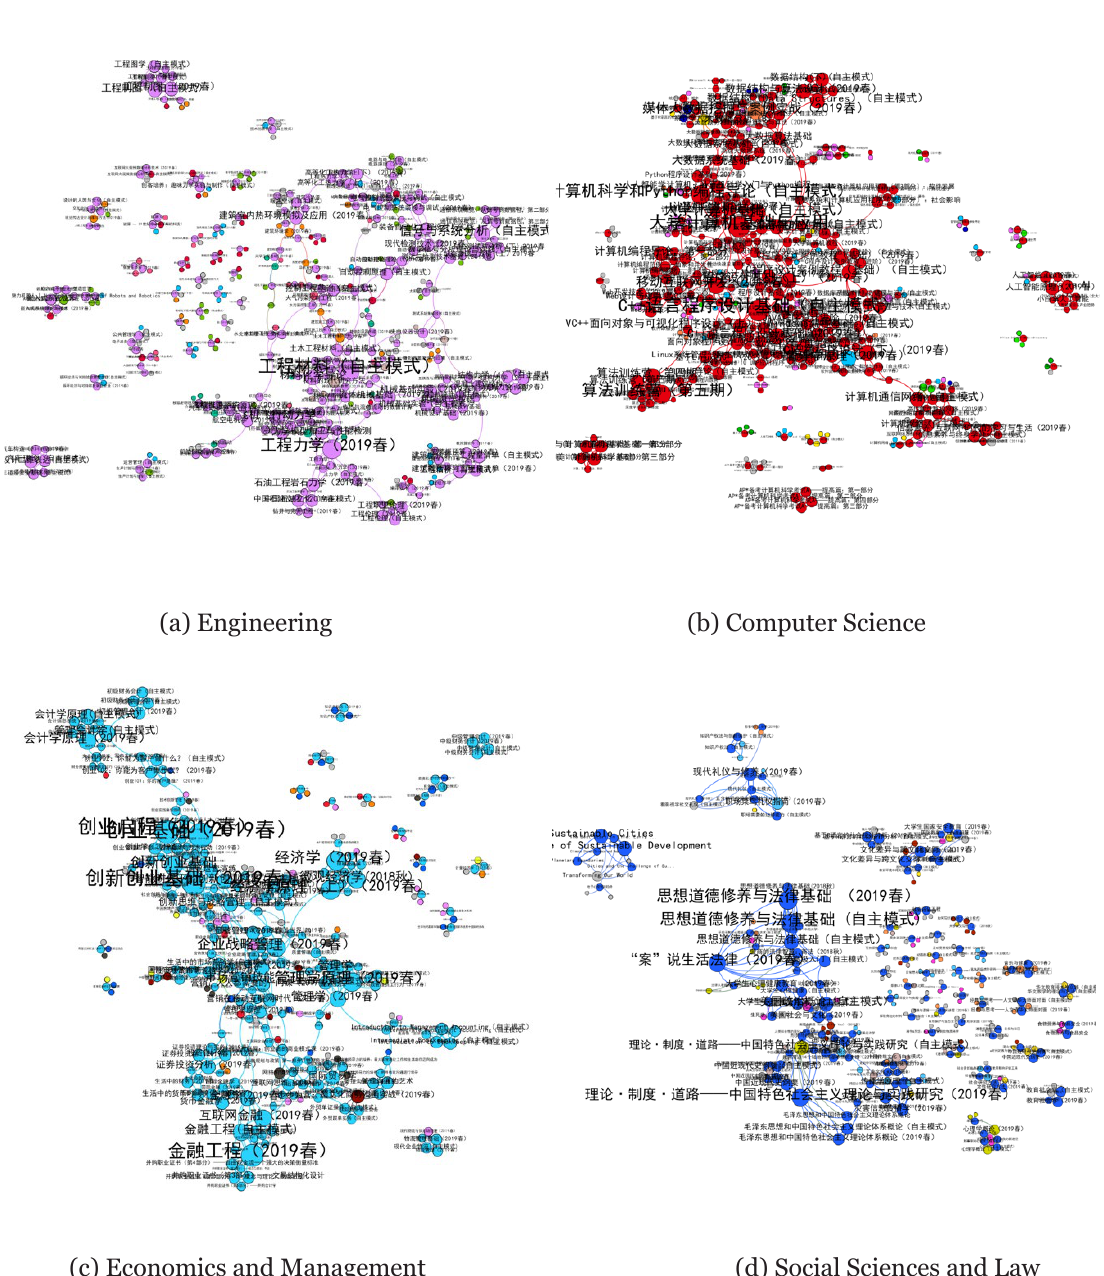
Figure 3 Recommendation Networks of Four Different